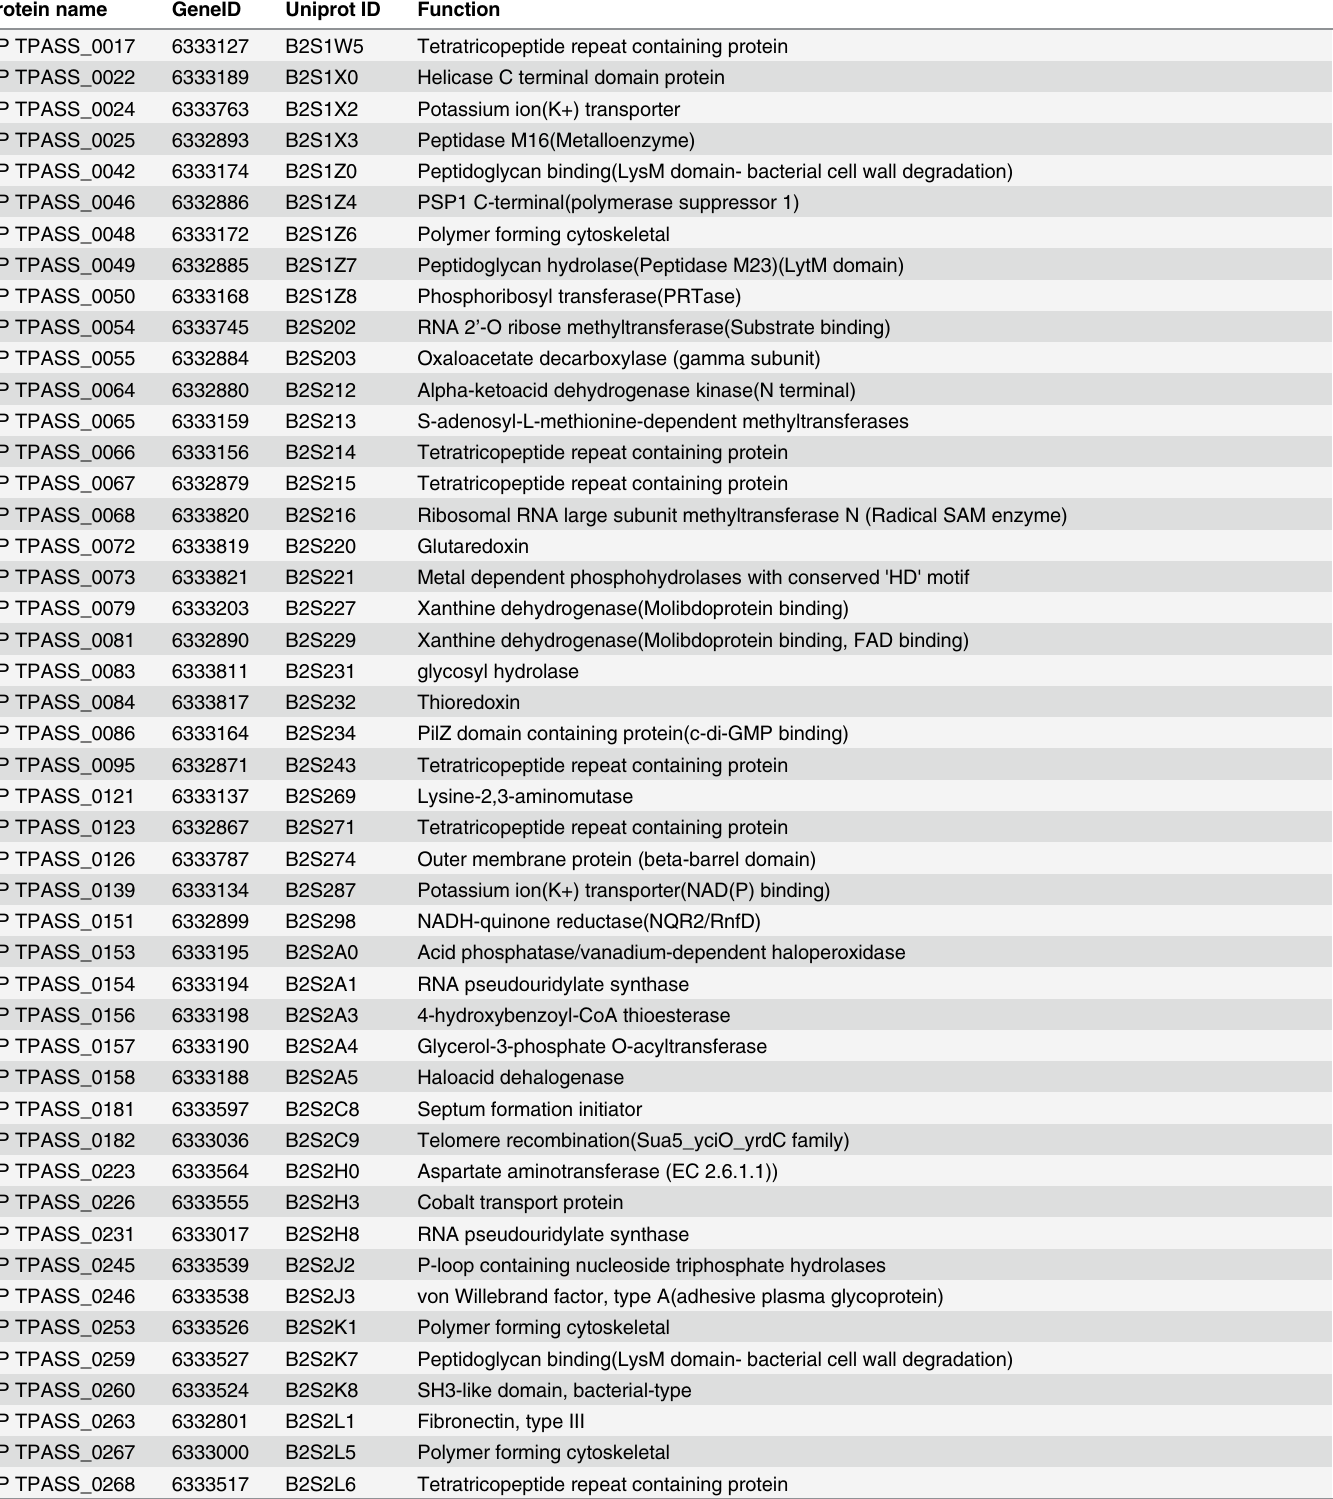
Table 1. Functionally annotated HPs from T . pallidum ssp . pallidum